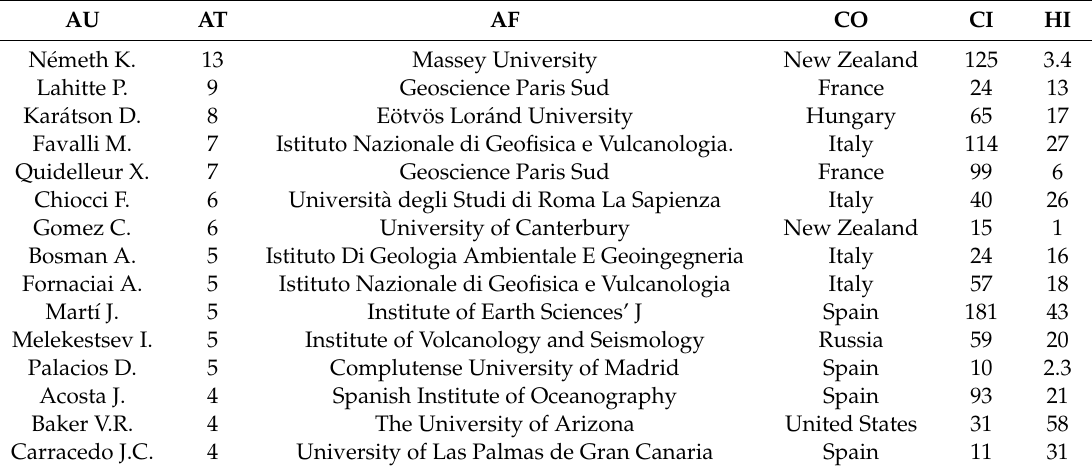
Table 1. Main authors considering the number of citations